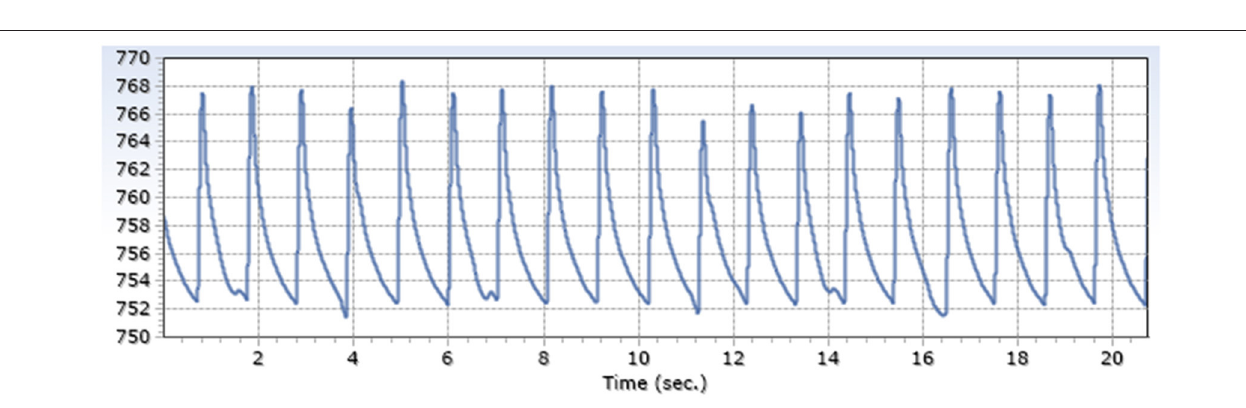
TABLE 1 | Individual maximum pressure amplitude measured intraluminally by fiber optic pressure sensoring. v1